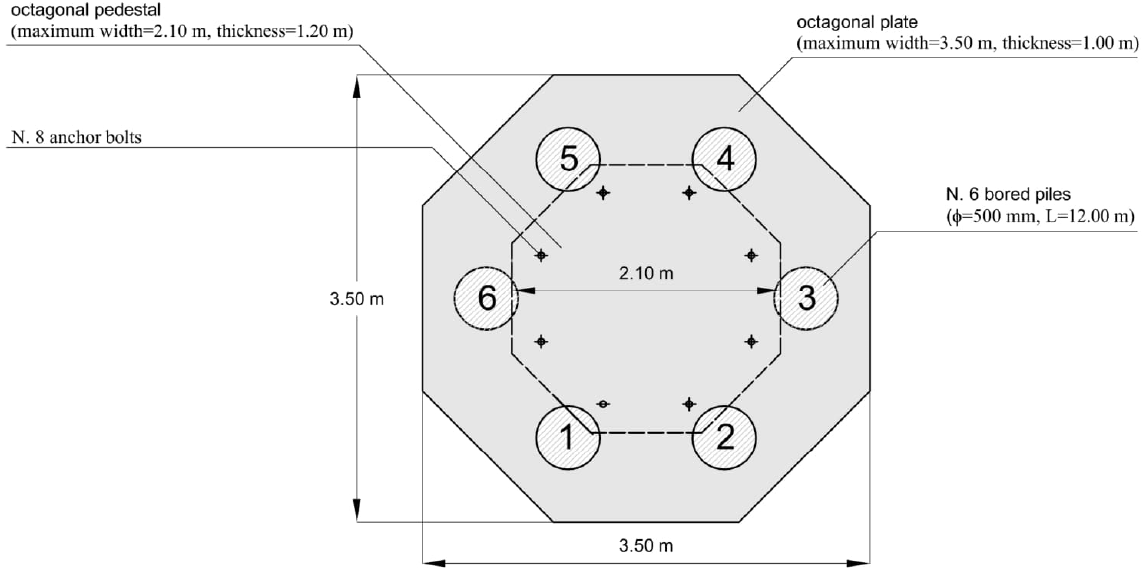
Figure 12. Plan view of the basement.